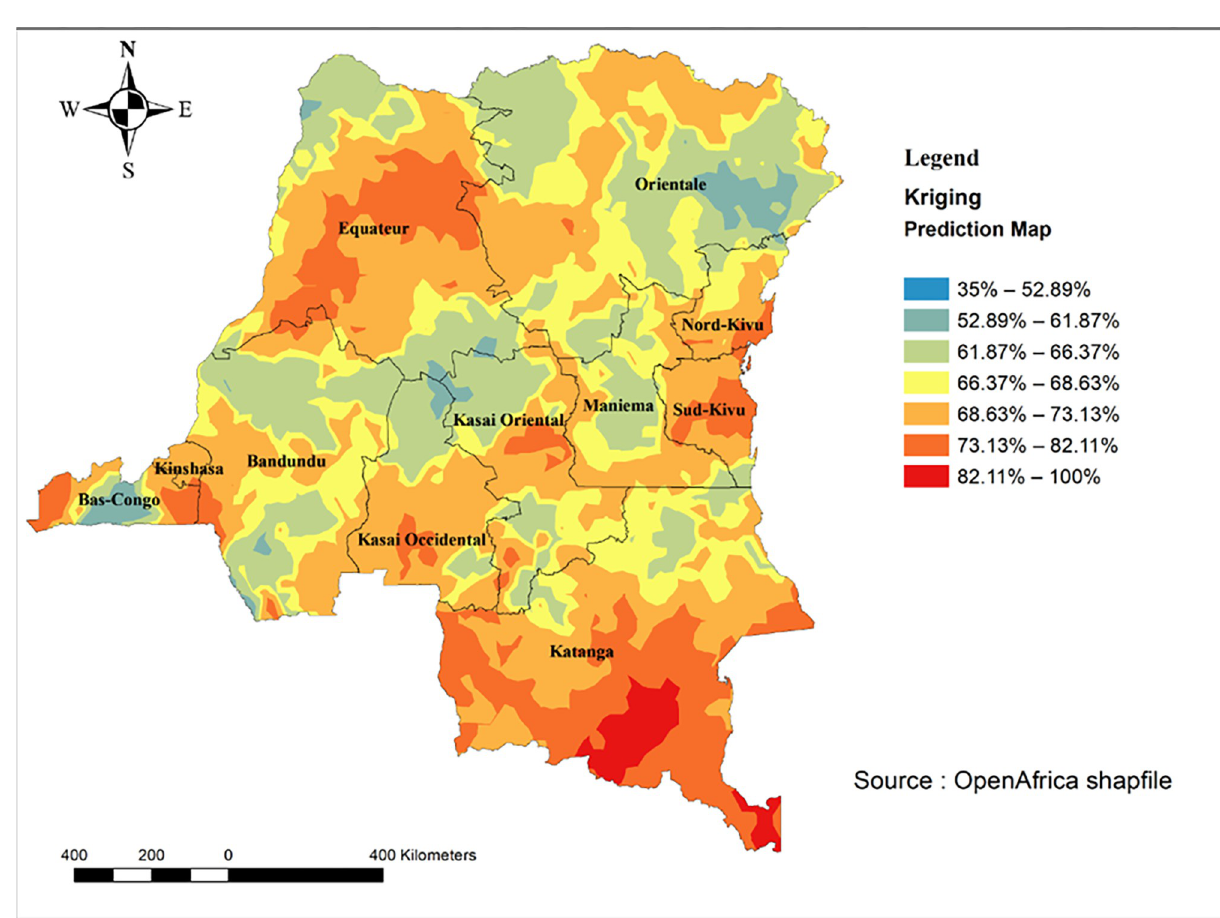
Fig 7. Spatial interpolation results of high-risk fertility behaviours among married women in the Democratic Republic of the Congo.